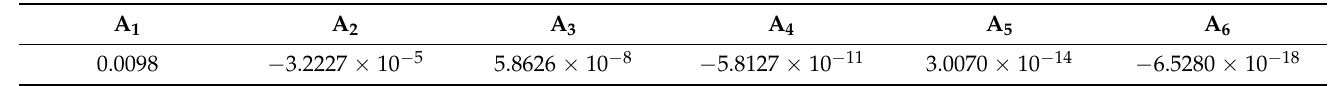
Figure 10. VCRplus back-up contour. Table 5. Coefficients of the VCRplus roll contour.